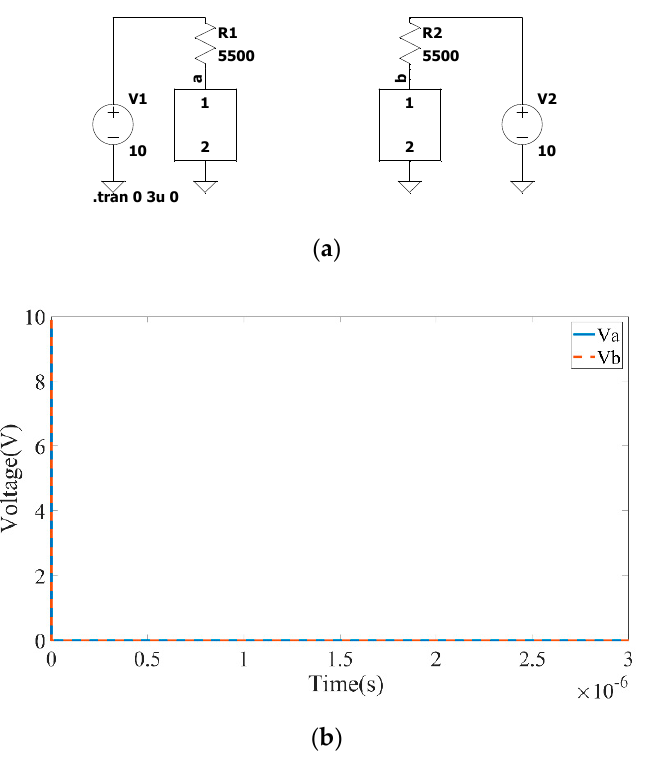
Figure 8. The two cells are uncoupled and in sleeping mode; ( a ) is the configuration of two uncoupled cells ( b ) shows there is no oscillation. After coupling, it is in wake-up mode, as shown in Figure 9. Figure 9b shows that the voltage drops from the initial 10 V to oscillate near 0 V.